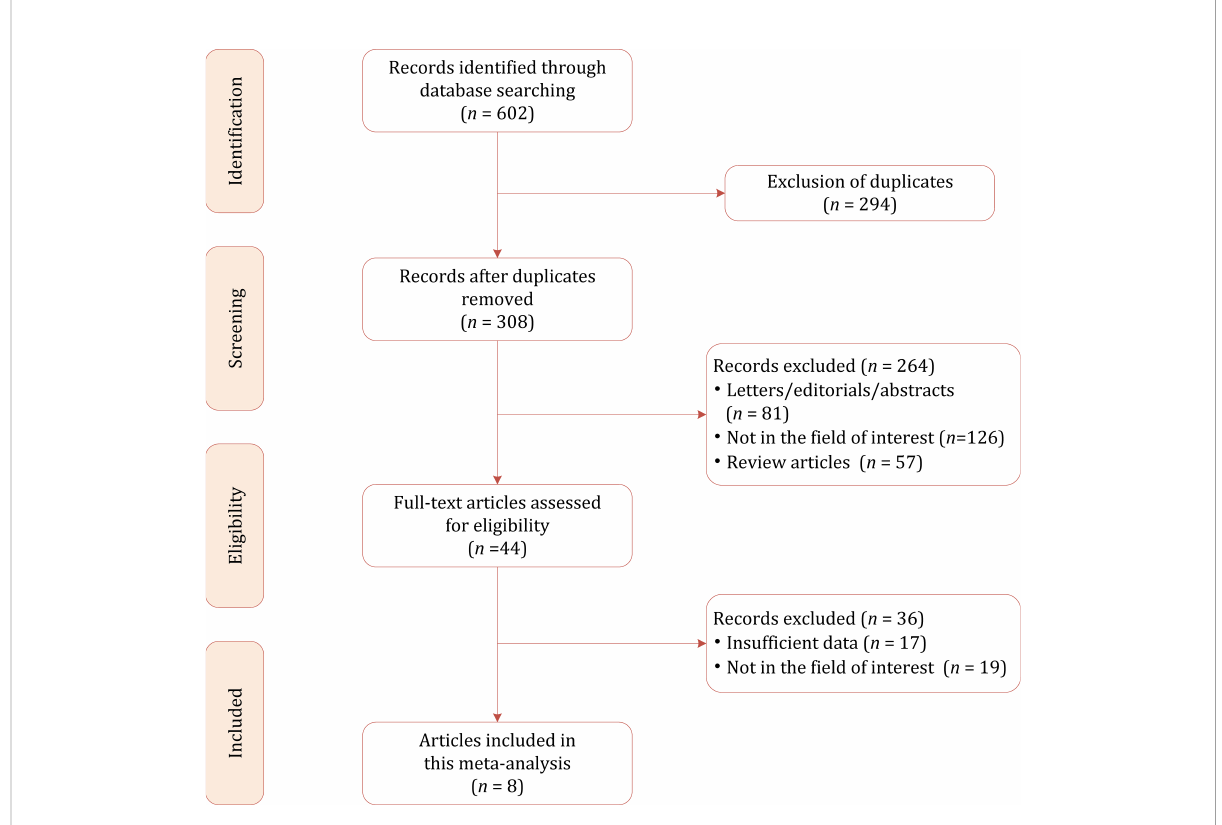
FIGURE 1 Study selection process for the systematic review and meta-analysis.